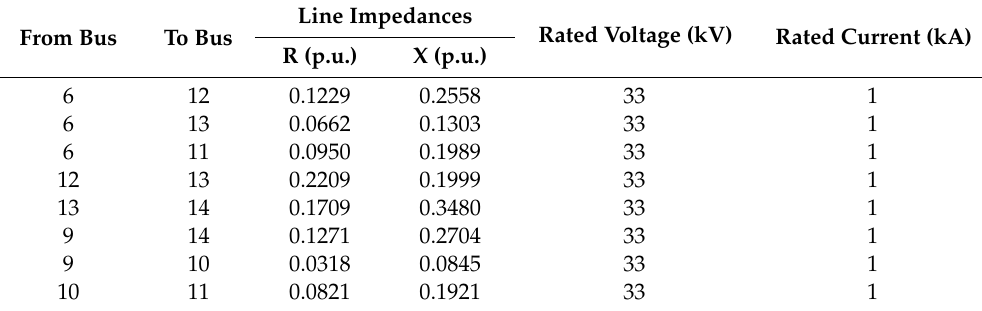
Table 4. System line parameters.